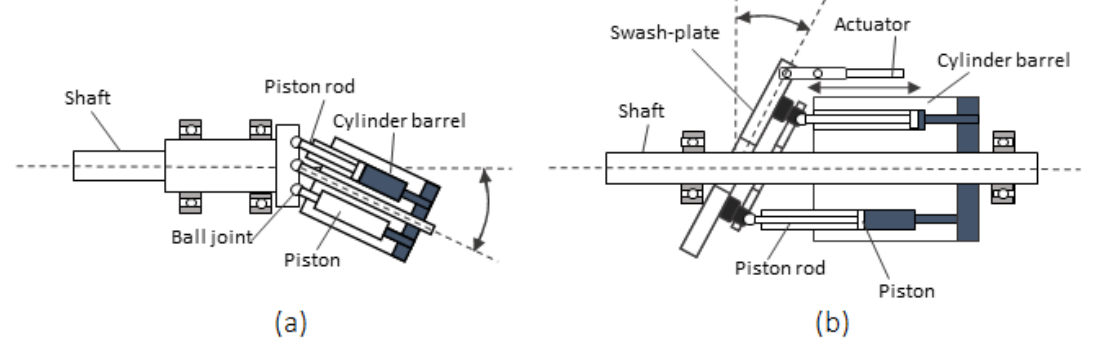
Figure 9. The bent-axis ( a ) and swash-plate ( b ) hydraulic